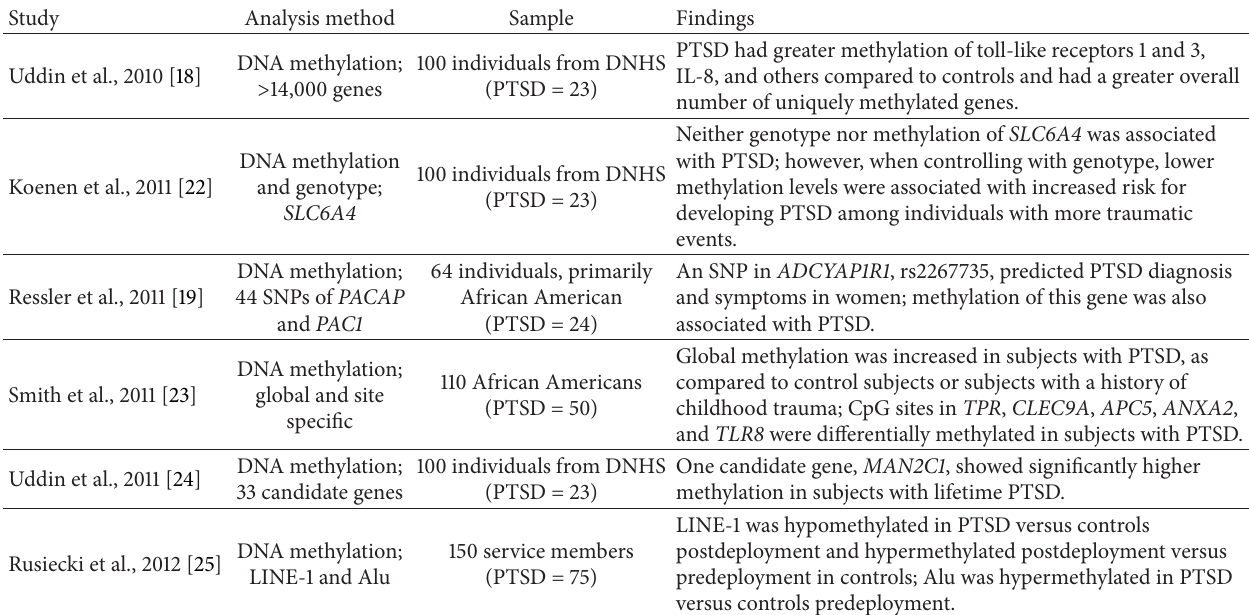
Table 1: Epigenetics